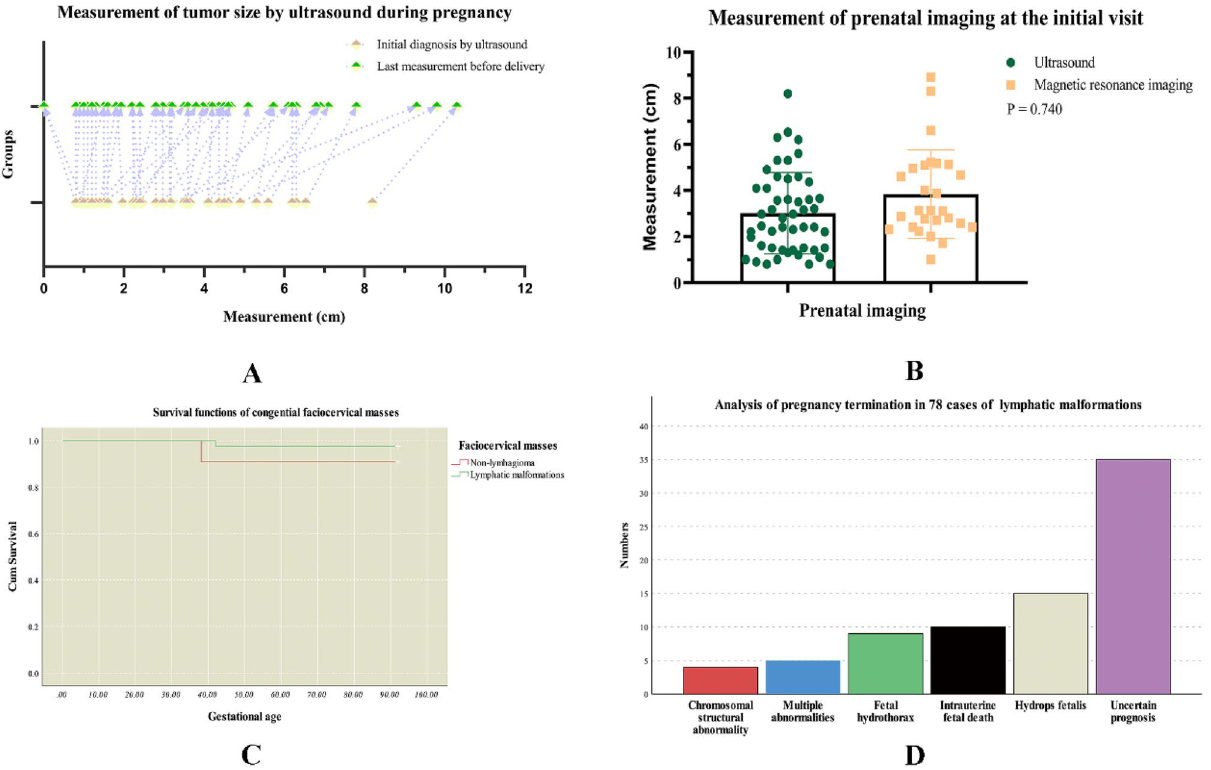
Figure 1. The figures show the survival information and prenatal imaging features of fetal facio-cervical masses.